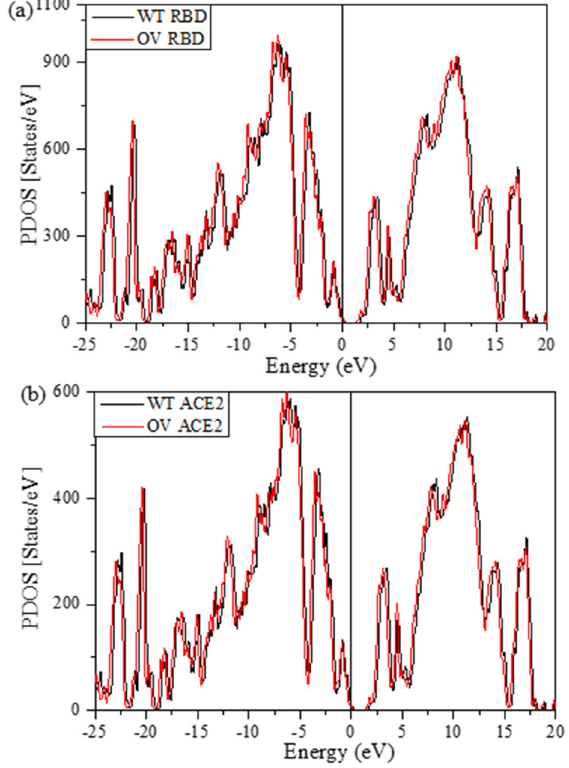
Figure 7. PDOS for ( a ) RBD and ( b ) ACE2. Each panel contains both WT and OV models. Interaction between RBD and ACE2 is illustrated in Figure 8 with the AABP values.